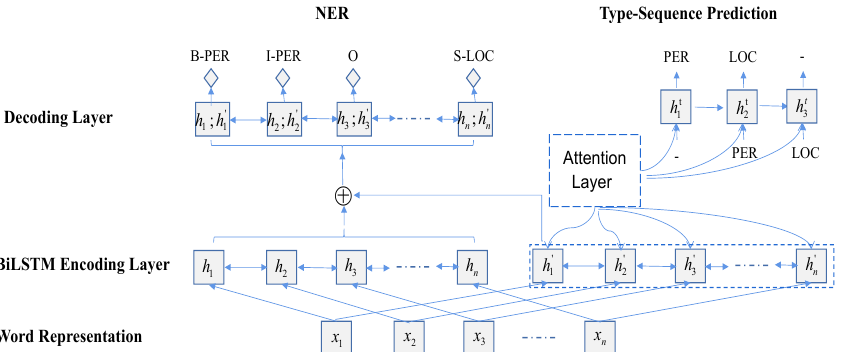
Figure 2. Main architecture of the joint model. The left part is the NER module and the right part is the TSP module. For NER, words tagged with O are outside of named entities and the B-XXX and I-XXX tag refer to the beginning and inside of a named entity of type XXX,